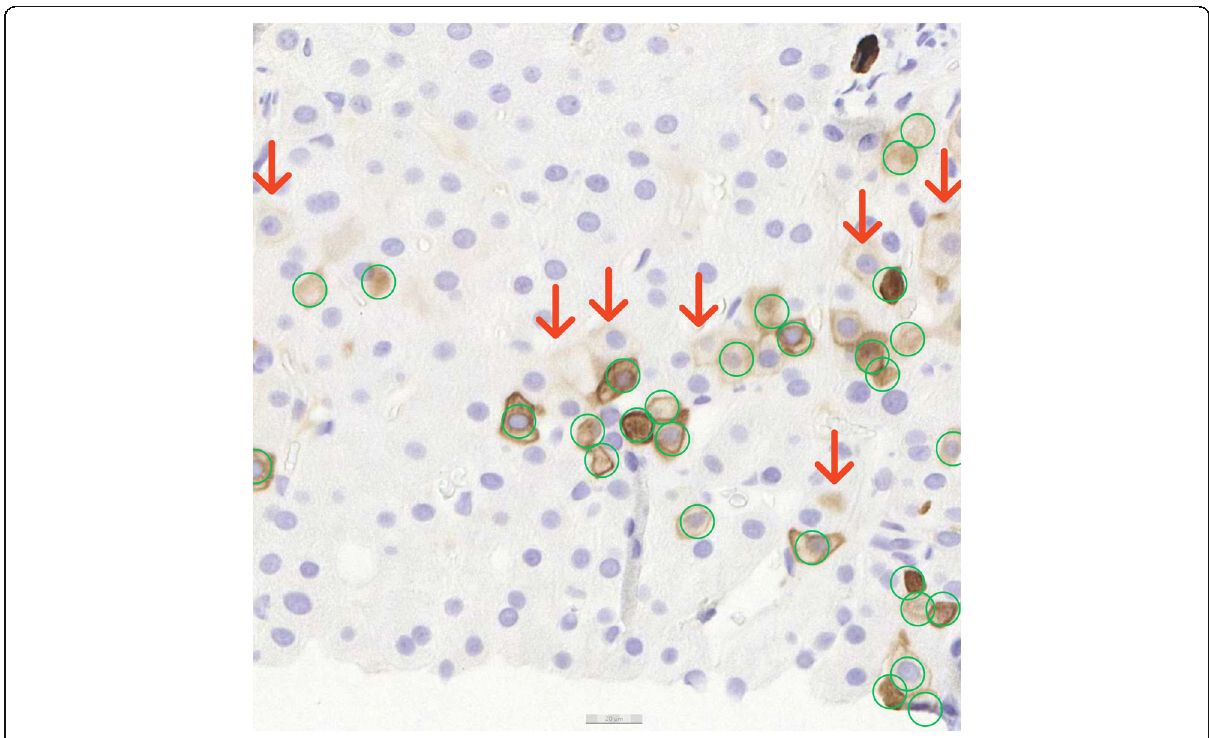
Fig. 2 Cut-off staining intensity for K7-positive hepatocytes. Cells pointed with red arrows are considered negative, because they are stained too lightly. Thus, they are excluded from the training annotations made for the AI model. The darker brown hepatocytes circled in green were considered positive. They were annotated in the training phase to demonstrate and teach the AI model what K7-positive hepatocytes look like